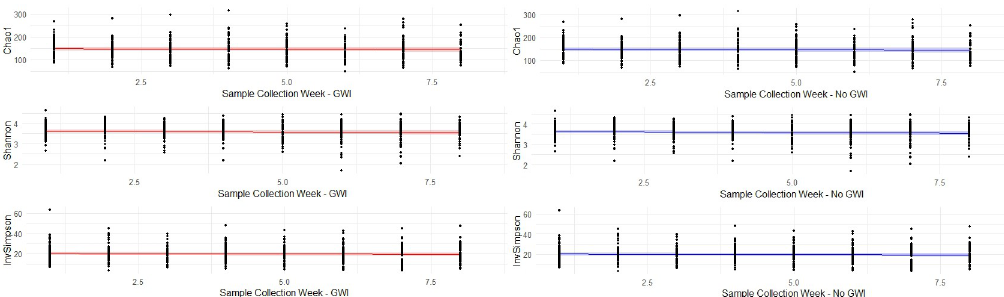
Fig 3. Linear mixed-effects modeling of alpha diversity by week. Red line is those with GWI and blue line is the controls. Lighter bands represent the 95% confidence interval of the regression line.